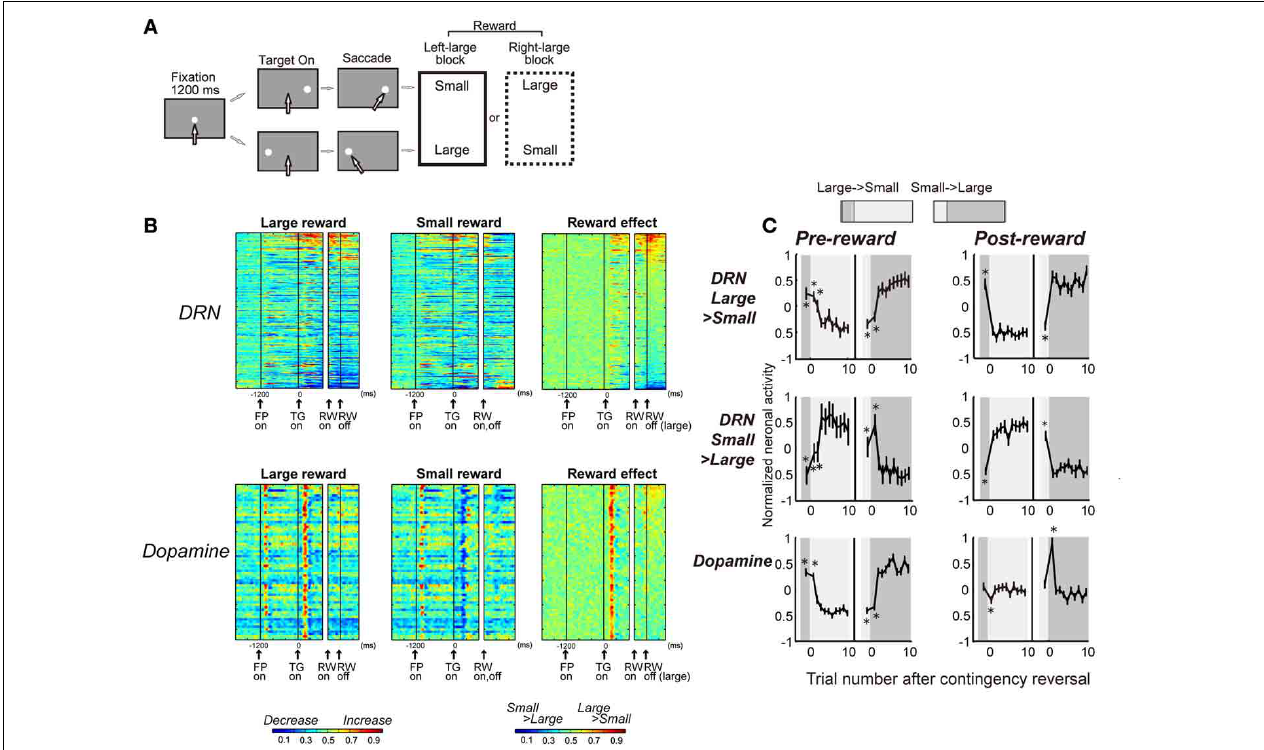
after reward onset for DRN neurons; 0–400ms after reward onset for dopamine neurons) is shown on the right. For each graph, the left panel shows large-to-small reward reversal; the right panel shows small-to-large reward reversal. The large-reward trials are indicated by dark gray; the small-reward trials are indicated by clear areas (as in the top). Shown are the mean and SE of the normalized neuronal activity for the n-th trial after contingency reversal. The asterisks ( ∗ ) indicate activity that was significantly different from the activity in the last five trials of the block with the reversed contingency ( p < 0 . 01, Mann-Whitney U -test). Modified from (Nakamura et al.,